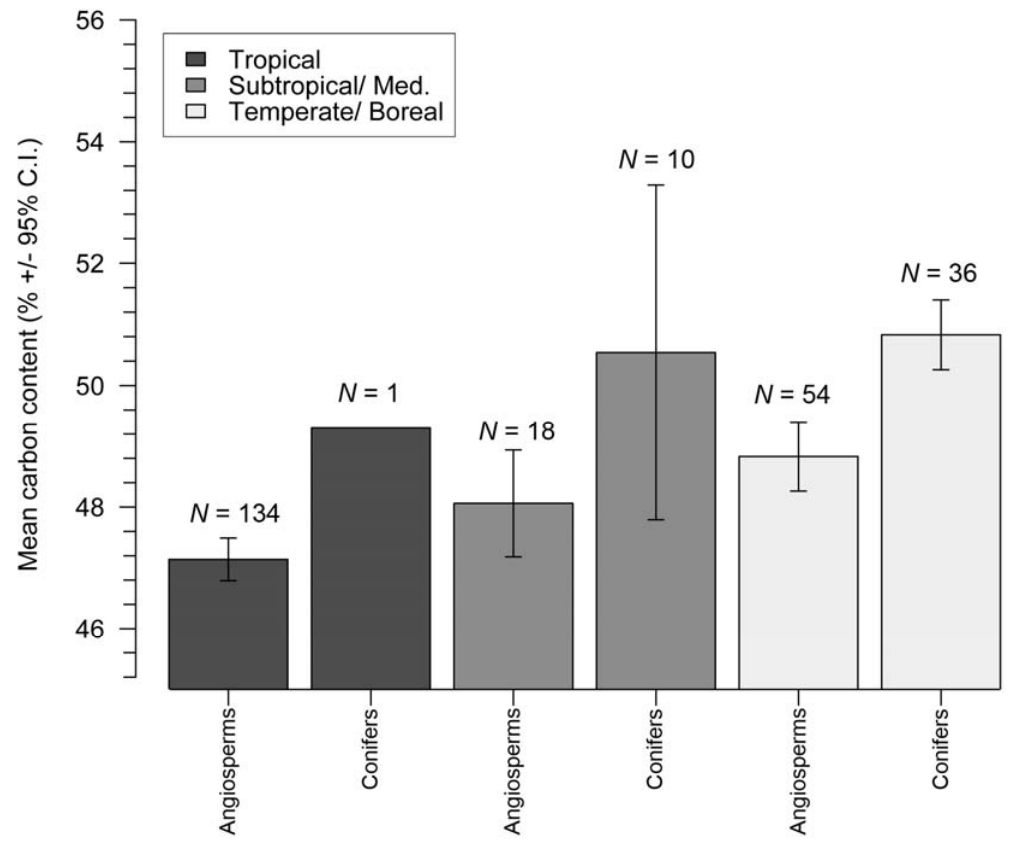
Figure 1. Comparisons of wood carbon content for 253 trees species grouped across three biomes (tropical, subtropical/Mediterranean, temperate/boreal) and two tree types (angiosperms, conifers). Height of each bar represents a mean wood C content for each grouping estimated as least squares means, and error bars represent 95% confidence intervals. Sample sizes ( N species) for each grouping are represented above each